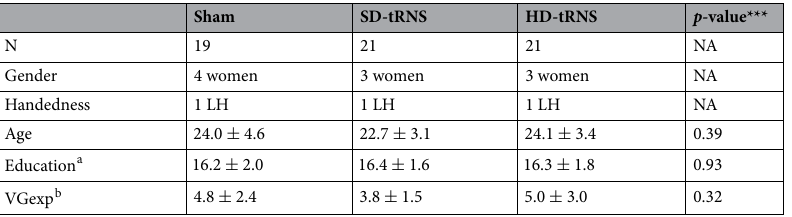
Table 1. Participants’ demographics (mean ± SD). a Education is measured on a scale from 1 to 20 (with 12 = high school degree). b Video Game experience (VGexp) is measured by a questionnaire and range on a scale from 0 to 10. ***ANOVA’s were performed for Age and Education, and a Kruskal-Wallis was performed for VGexp (available in Supplementary Information). LH